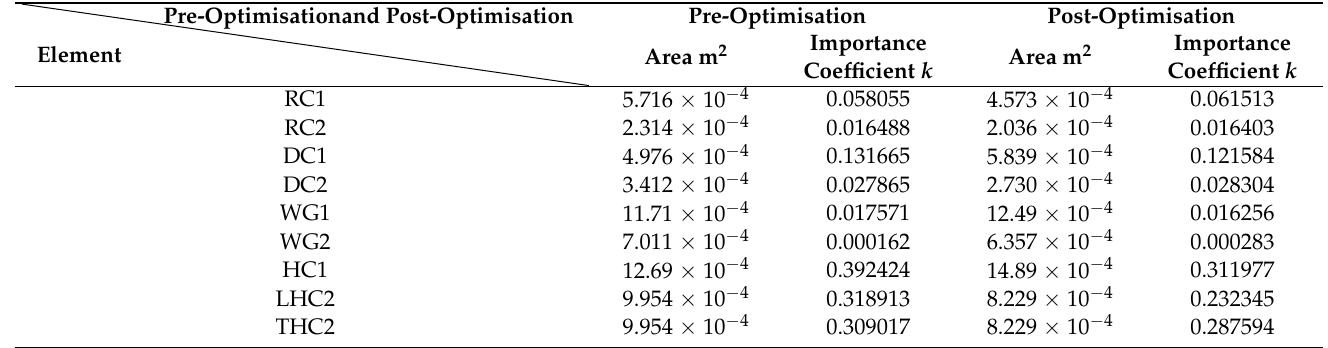
Figure 2. Iterative process of element section optimisation. Table 5. Cross-sectional areas and importance coefficients of the elements before and after optimi- sation.